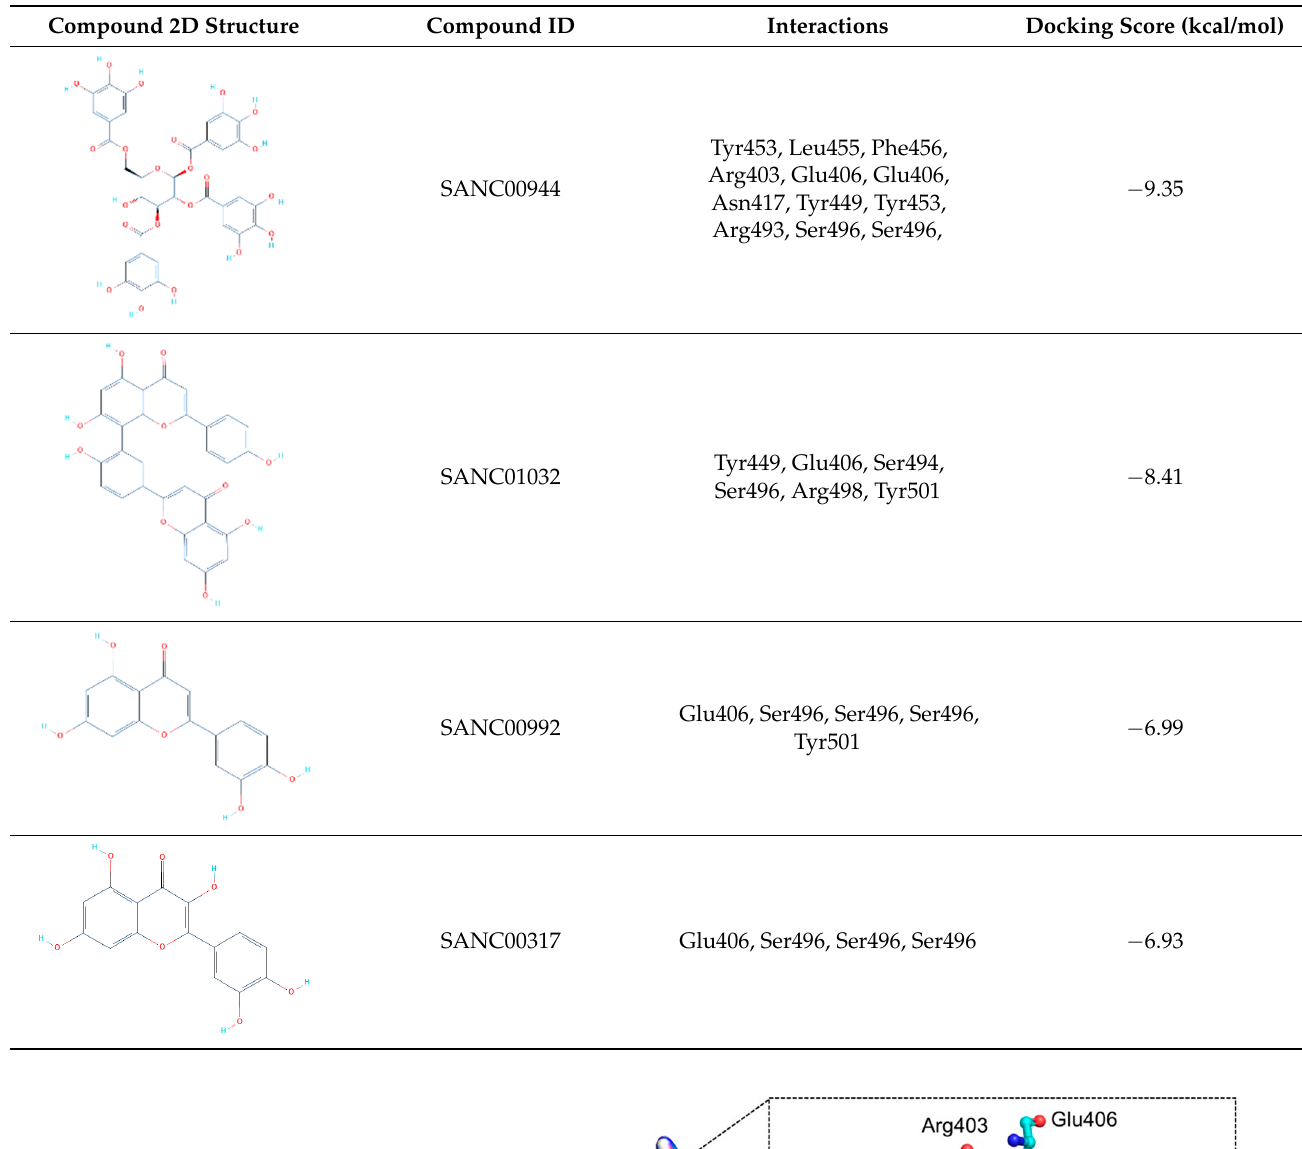
Table 1. Top four hits identified through the molecular search. The table shows the 2-dimensional structures of the tope hits, their IDs, interactions, and docking scores.